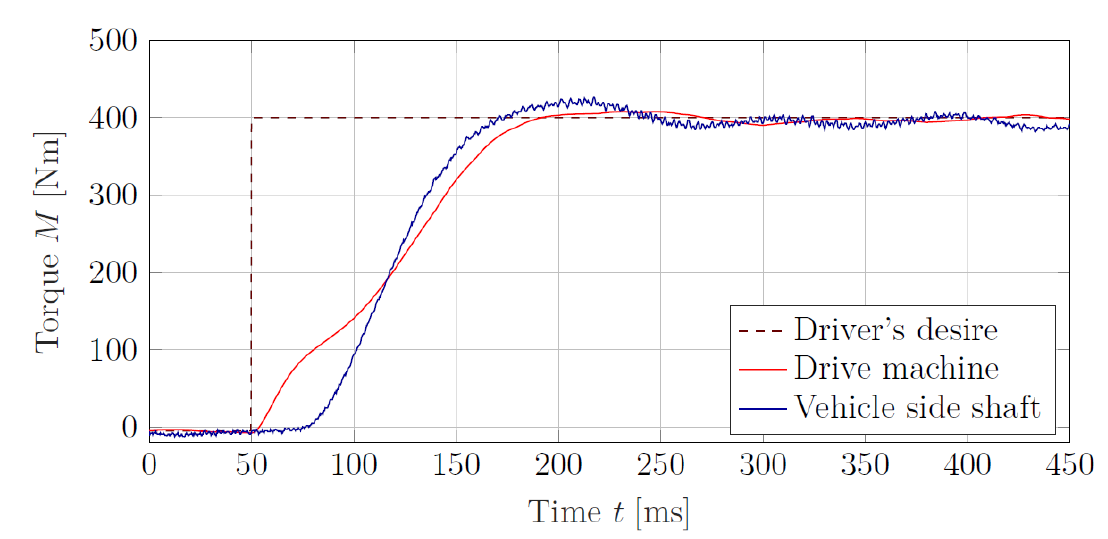
Figure 16. Torque curves as a result of the setpoint step in the driver′s desired torque with prefilter and active anti-jerk control while tip-in.